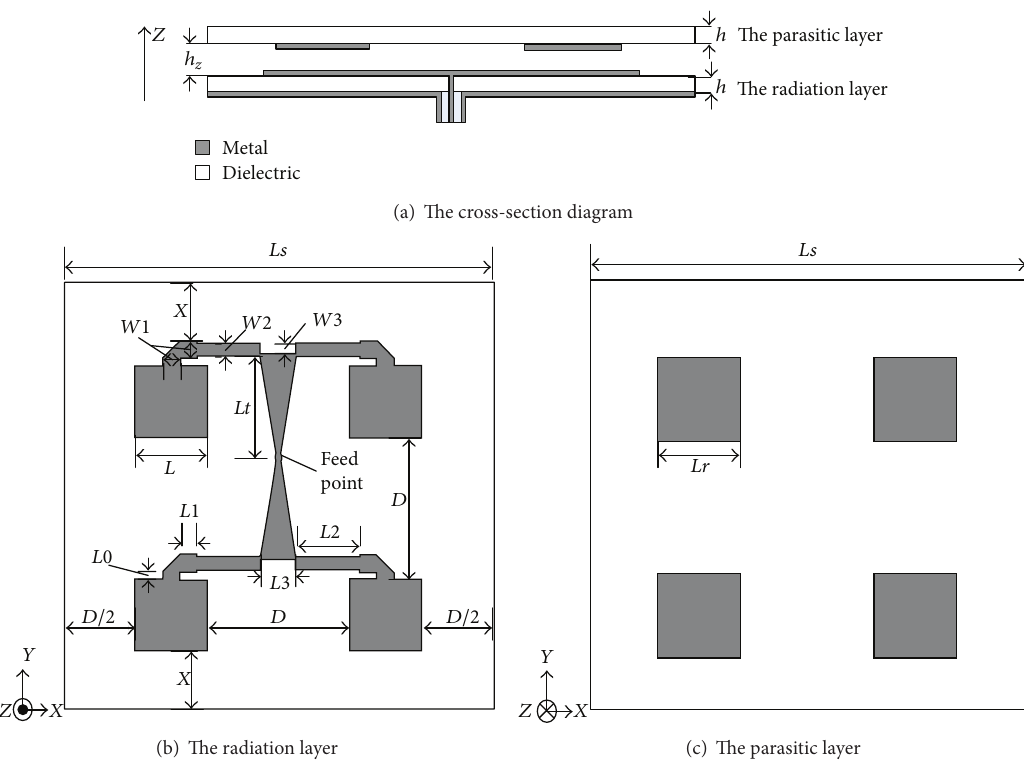
Figure 4: The configuration of the two-layer square patches 2 × 2 antenna array.